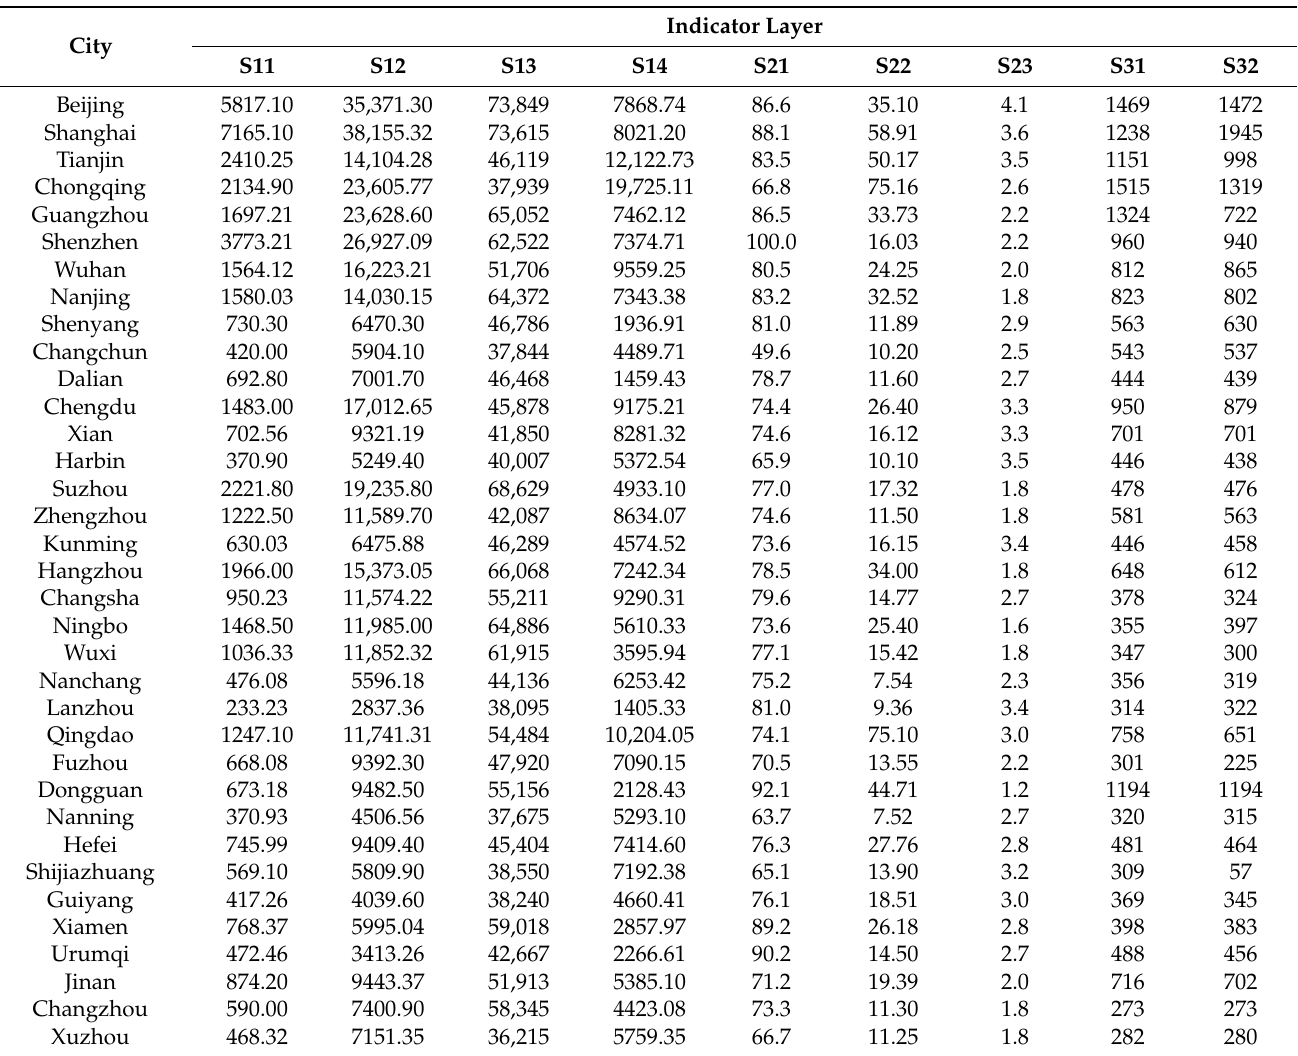
Table A2. Data of Supply